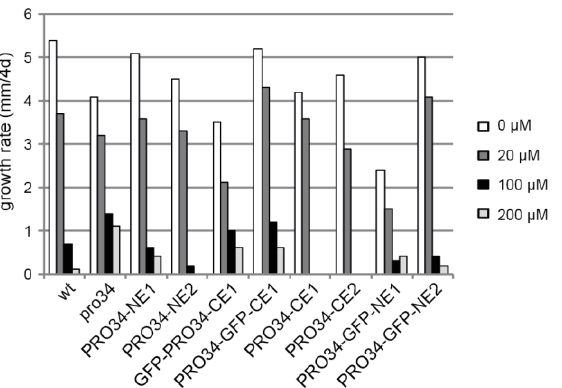
Figure 6. Mutant pro34 shows increased resistance to superoxide. The indicated strains were grown for four days on media with different paraquat concentrations as